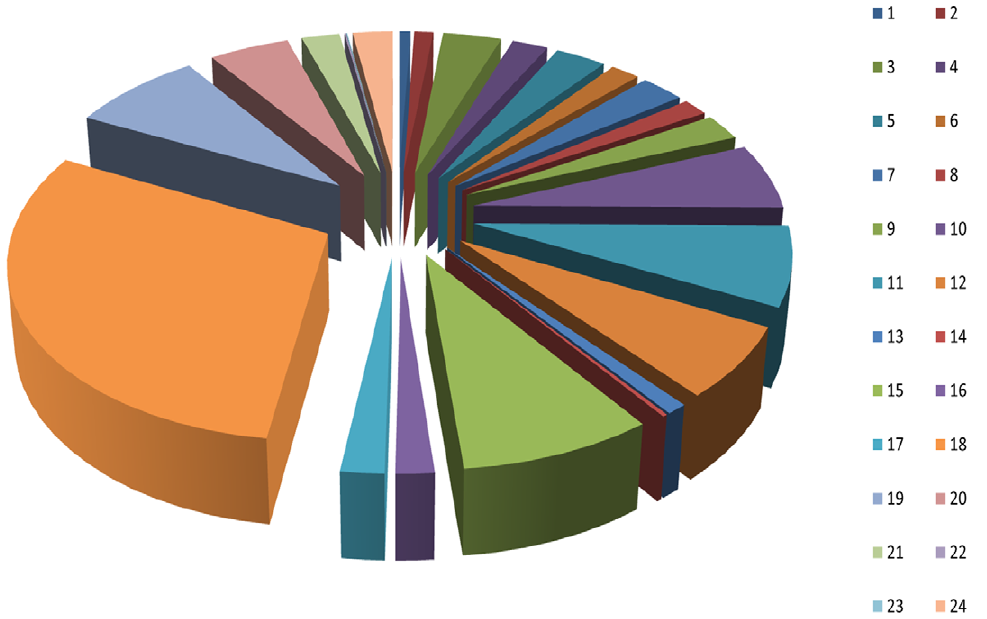
Figure 3. Clusters of orthologous groups (COG) classifications of unique M.nipponense sequences. 1: RNA processing and modification; 2: chromatin structure and dynamics; 3: energy production and conversion; 4: cell cycle control, cell division, chromosome partitioning; 5: amino acid transport and metabolism; 6: nucleotide transport and metabolism; 7: carbohydrate transport and metabolism; 8: coenzyme transport and metabolism; 9: lipid transport and metabolism; 10: translation, ribosomal structure and biogenesis; 11: transcription; 12: replication, recombination and repair; 13: cell wall/membrane/envelope biogenesis; 14: cell motility; 15: posttranslational modification, protein turnover, chaperones; 16: inorganic ion transport and metabolism; 17: secondary metabolites biosynthesis, transport and catabolism; 18: general function prediction only; 19: function unknown; 20: signal transduction mechanisms; 21: intracellular trafficking, secretion, and vesicular transport; 22: defense mechanisms; 23: nuclear structure; and 24: cytoskeleton.